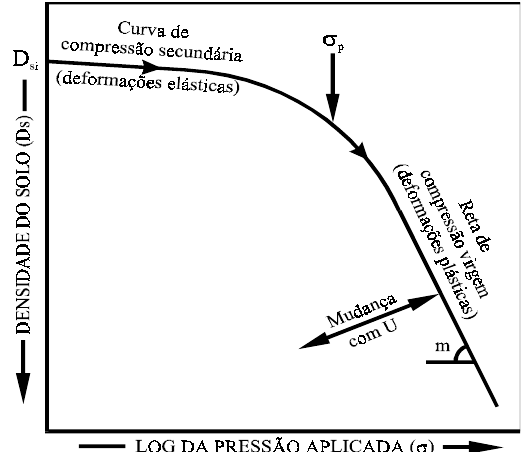
Figura 1. Curva de compressão do solo (Dias Junior, 1994), mostrando a curva de compressão secundária, reta de compressão virgem com suas respectivas regiões de deformações elásticas e plásticas ( sssss é a pressão de p preconsolidação, sssss é a pressão crítica, m é o c índice de compressão, U é a umidade do solo e Ds é a densidade do solo i